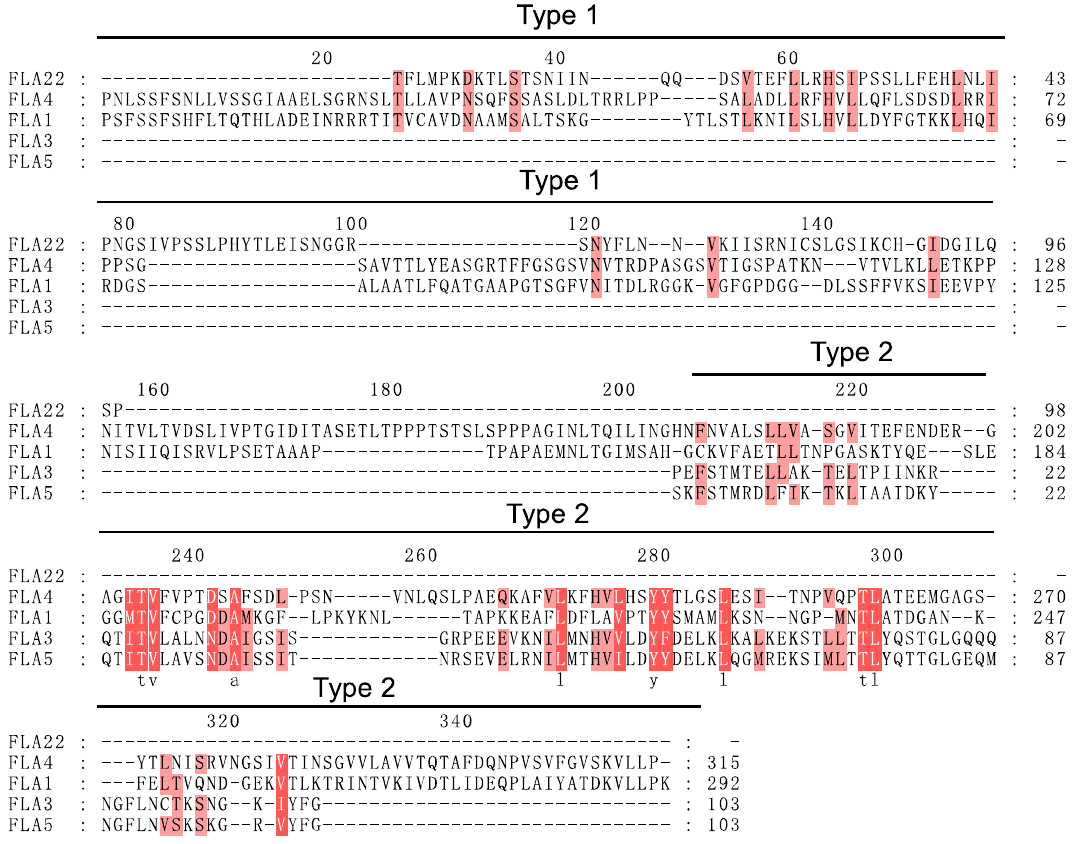
Figure 1. Multiple sequence alignment of representative FLA sequences. Fasciclin domains were divided into two types (Type 1 and Type 2). Residues with high similarity (80%, 60%) were highlighted in dark pink and light pink, respectively.